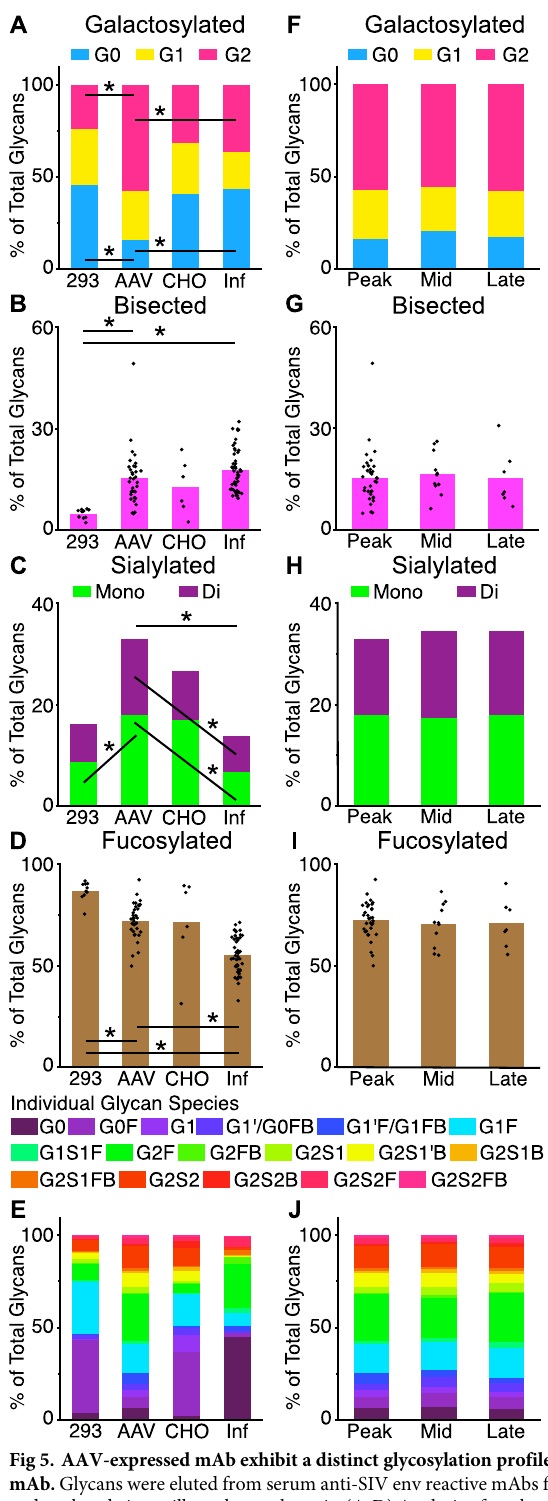
Fig 5. AAV-expressed mAb exhibit a distinct glycosylation profile from in vitro purified or naturally secreted mAb. Glycans were eluted from serum anti-SIV env reactive mAbs from passively immunized or SIV-infected animals and analyzed via capillary electrophoresis. (A-D) Analysis of total grouped glycan species are displayed as a percent of total glycans (E) Individual glycan species of are quantified as a percent of all glycans and compared by derivation. (F-I) Analysis of total grouped glycan species of AAV expressed NAbs are compared across time. (J) Individual glycan species of are quantified as a percent of all glycans and compared across time for AAV derived antibodies. (A-D, F-I)